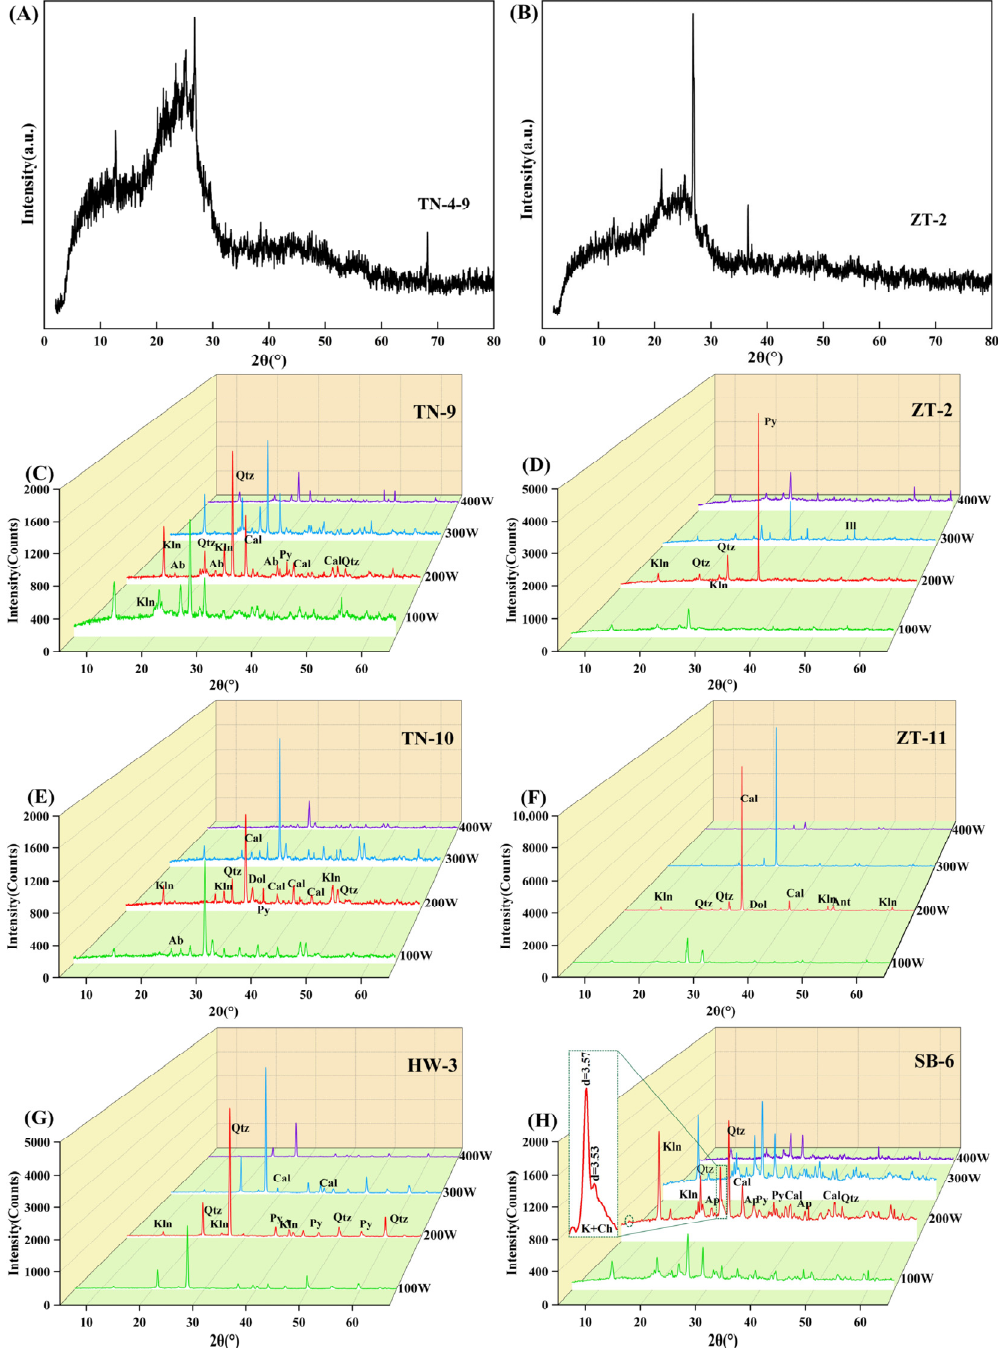
Figure 5. XRD patterns of raw coal samples and LTAs by varied programs. ( A , B ) raw coal samples of TN-9 and ZT-2; ( C – H ) LTAs of coal samples obtained by varied programs. Kln: kaolinite. Chl: chlorite. Qtz: quartz. Cal: calcite. Py: pyrite. Ab: albite. Dol: dolomite. Ant: anatase. Ap: apatite. Ill: illite.